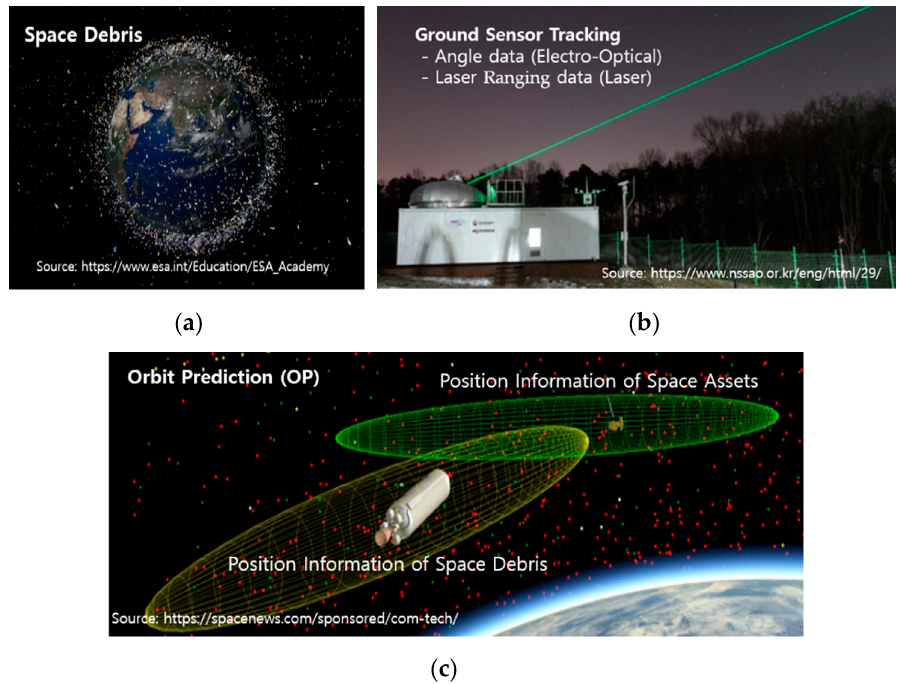
Figure 1. The ground sensor tracking and orbit prediction of space debris. ( a ) space debris; ( b ) ground sensor tracking; ( c ) orbit prediction [2–4] .